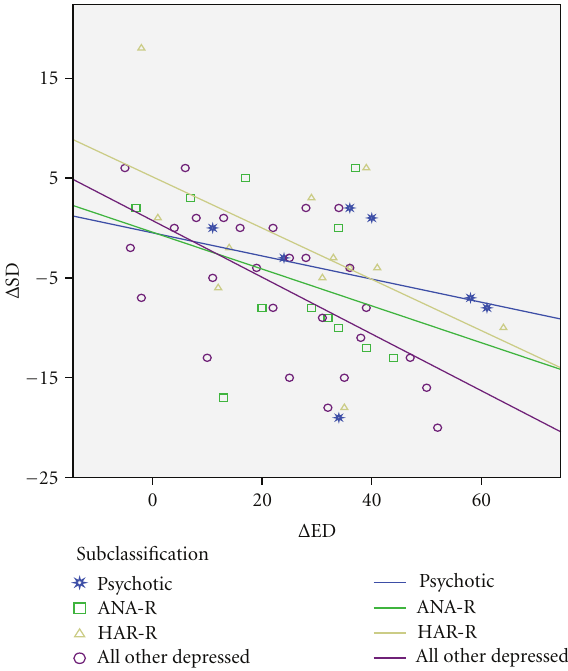
Figure 1: Negative relations (lines corresponding with regression coe ffi cients) between the change of Self-Directedness ( Δ SD) and the change of Emotional Dysregulation ( Δ ED) in 4 subcategories of depression. (1 = psychotic depression, 2 = ANA-R, 3 = HAR-R, and 4 = all other depressed patients).